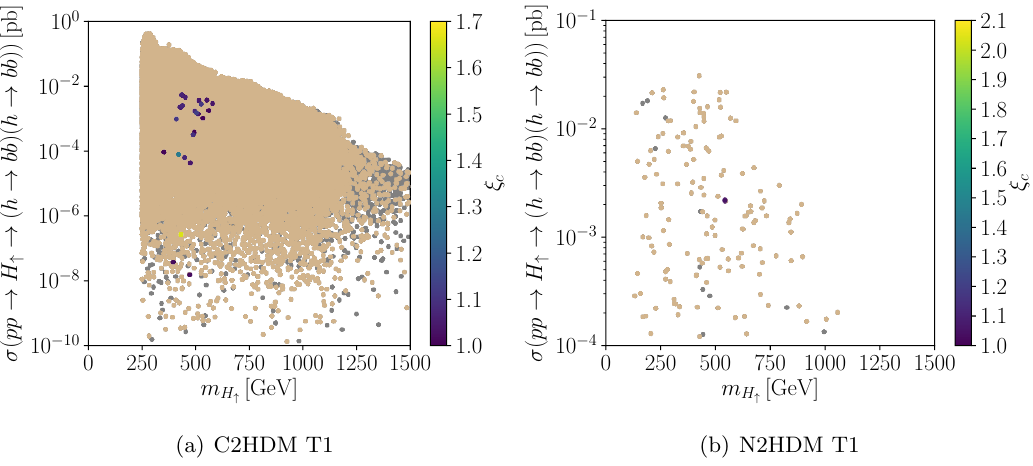
Figure 13 . T1: production rate of H " with subsequent decay into hh in the 4 b (cid:12)nal state versus m H for the C2HDM (left) and the N2HDM (right). The color code is the same as in (cid:12)gure 3. The " color bar indicates the strength of the phase transition for (cid:24) c are